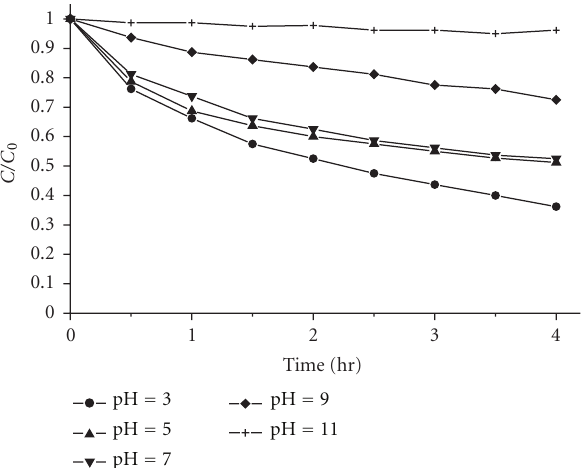
Figure 3: E ff ect of the pH on the photocatalytic reduction.